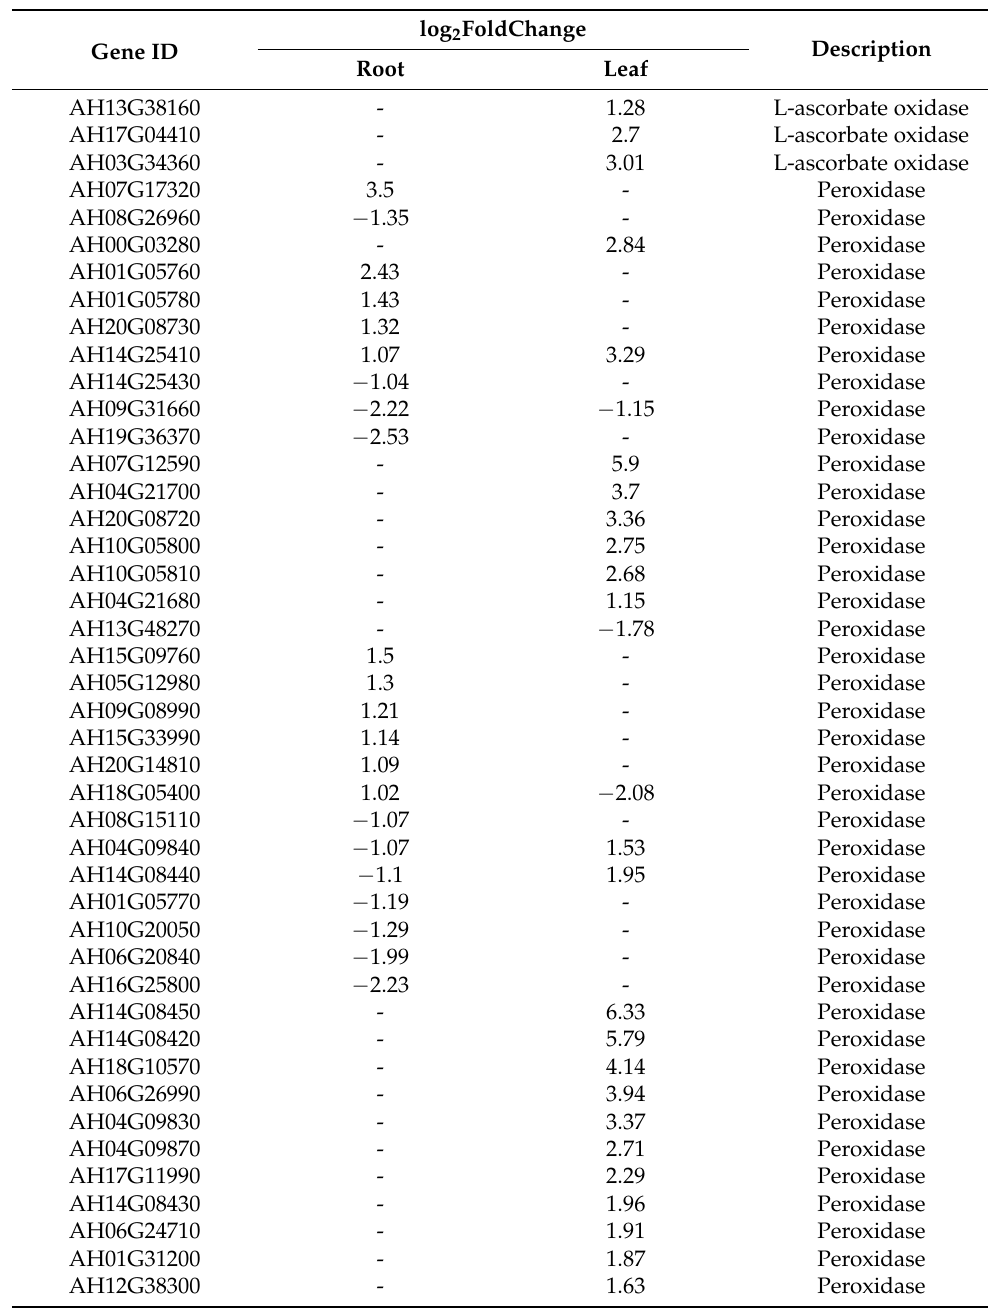
Table 6. Identifying DEGs that act as